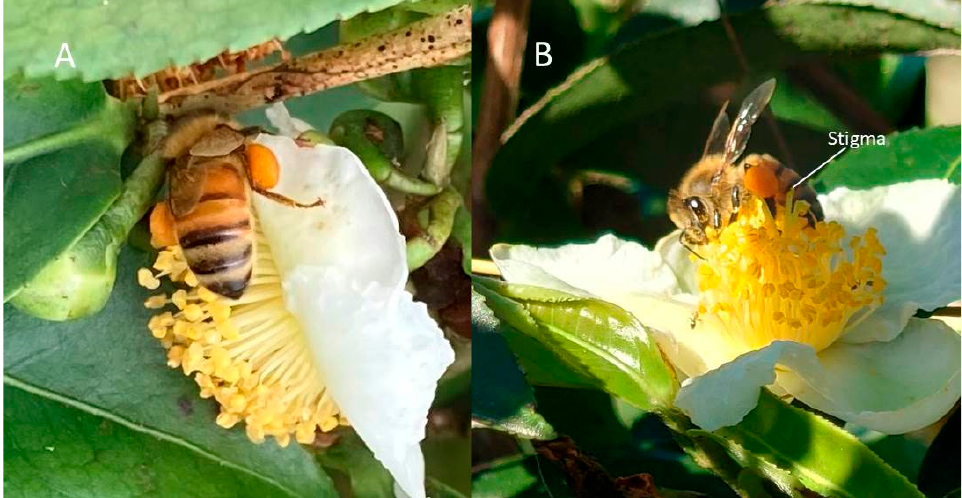
Figure 6. Bee pollination. ( A ) Anther superior flower; and ( B ) stigma superior flower of C. sinensis